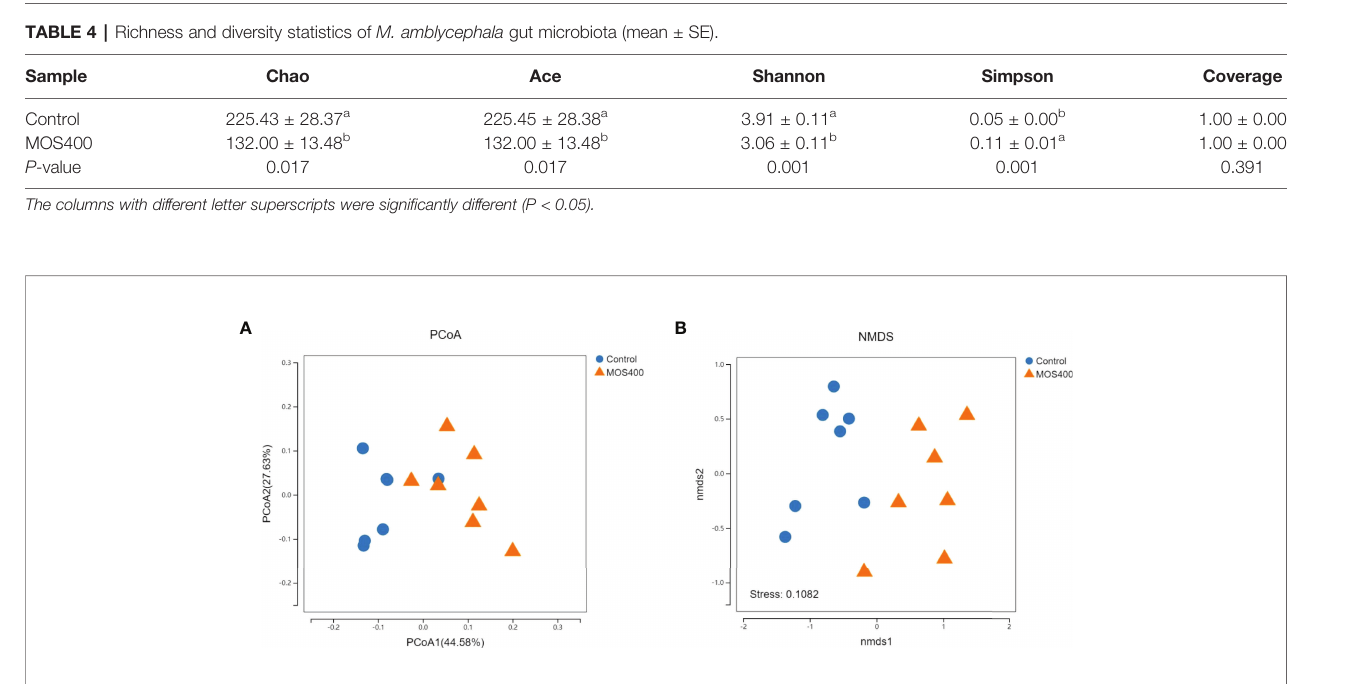
FIGURE 8 | Comparison of gut microbial composition between the control and MOS400 groups with weighted UniFrac PCoA analysis (A) and non-metric multidimensional scaling (NMDS) diagram (B) .